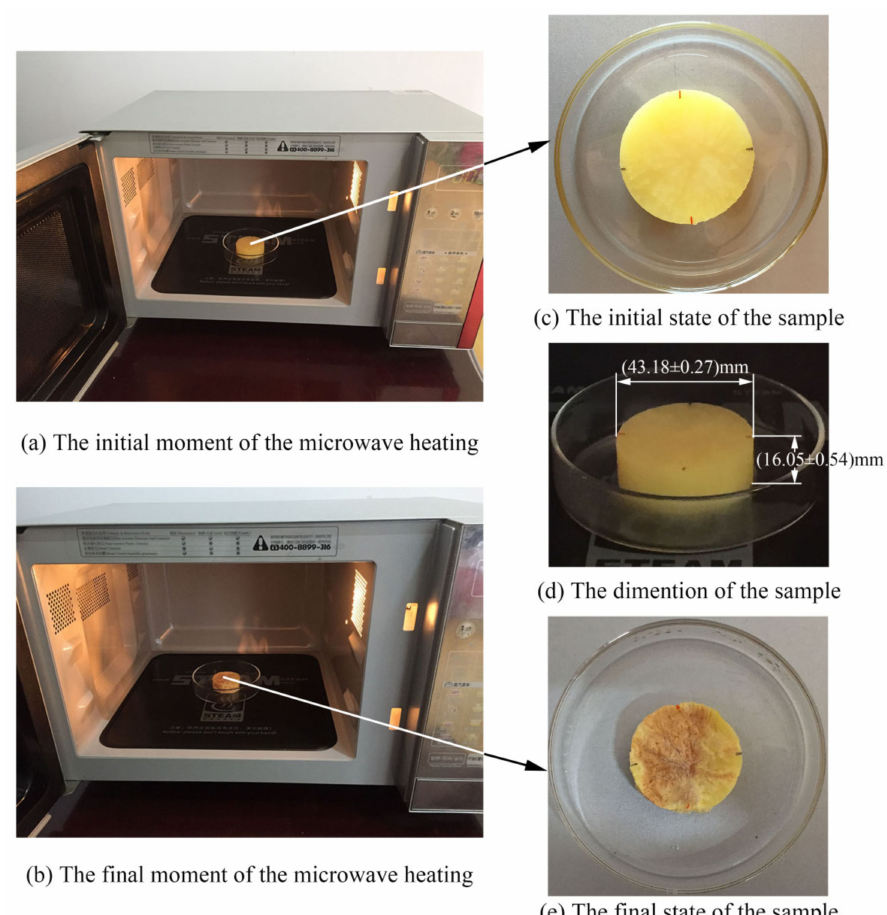
Figure 2. Descriptions of the validation experiment. ( a ) The initial moment of the microwave heating. ( b ) The final moment of the microwave heating. ( c ) The initial state of the sample. ( d ) The dimensions of the sample. ( e ) The final state of the